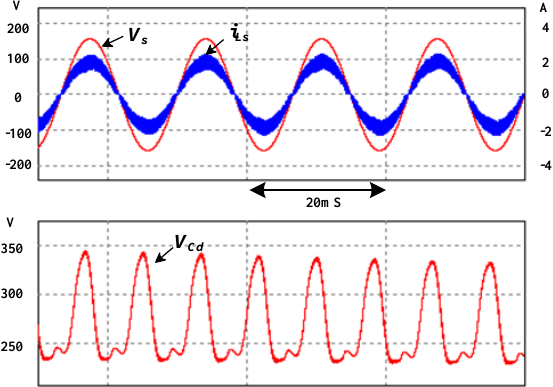
Figure 17. Simulation results for (top) switching control signals and (bottom) corresponding voltage and current of switch S 1 during negative half line cycle.